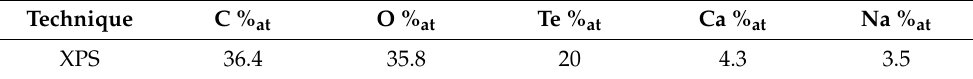
Figure 4. Broad scan XPS spectrum ( A ) and Te 3d XPS core level spectrum with the corresponding metallic and oxide components ( B ).